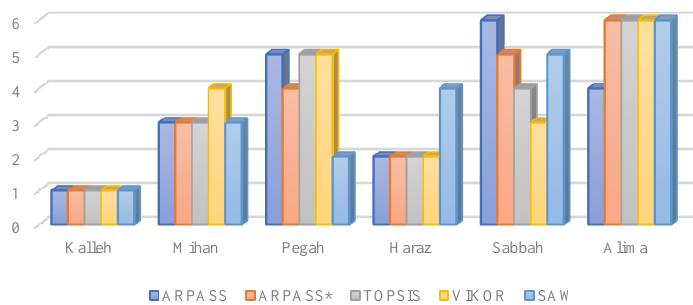
Figure 9. Comparative analysis of ranking results of the first six suppliers.